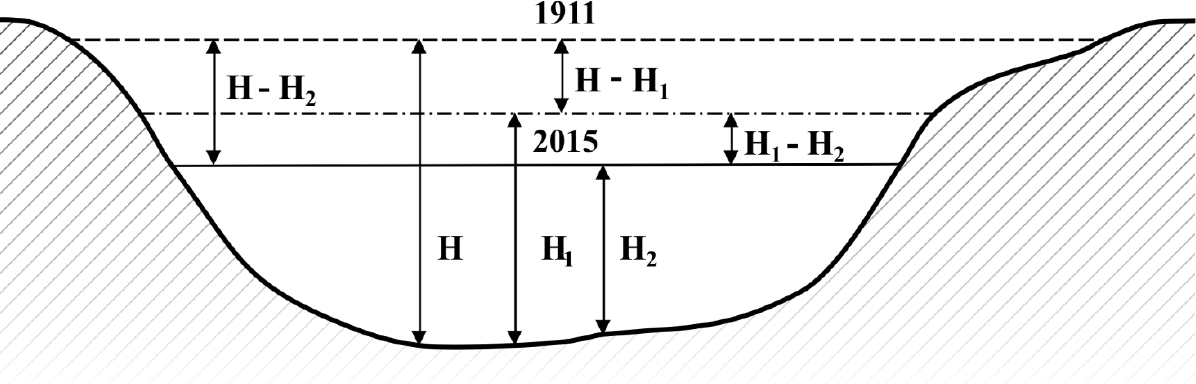
Figure 2. Changes in the surface level of the Dublany peatland in the years 1911–2015 caused by compaction and oxidation. Explanations: H = initial depth of the peat deposit (1882). H deposit (H ) if it were not compacted. H = current peat deposit depth (2015). H - H 2 2 due to oxidation. H - H = loss in peat thickness due to 1 2